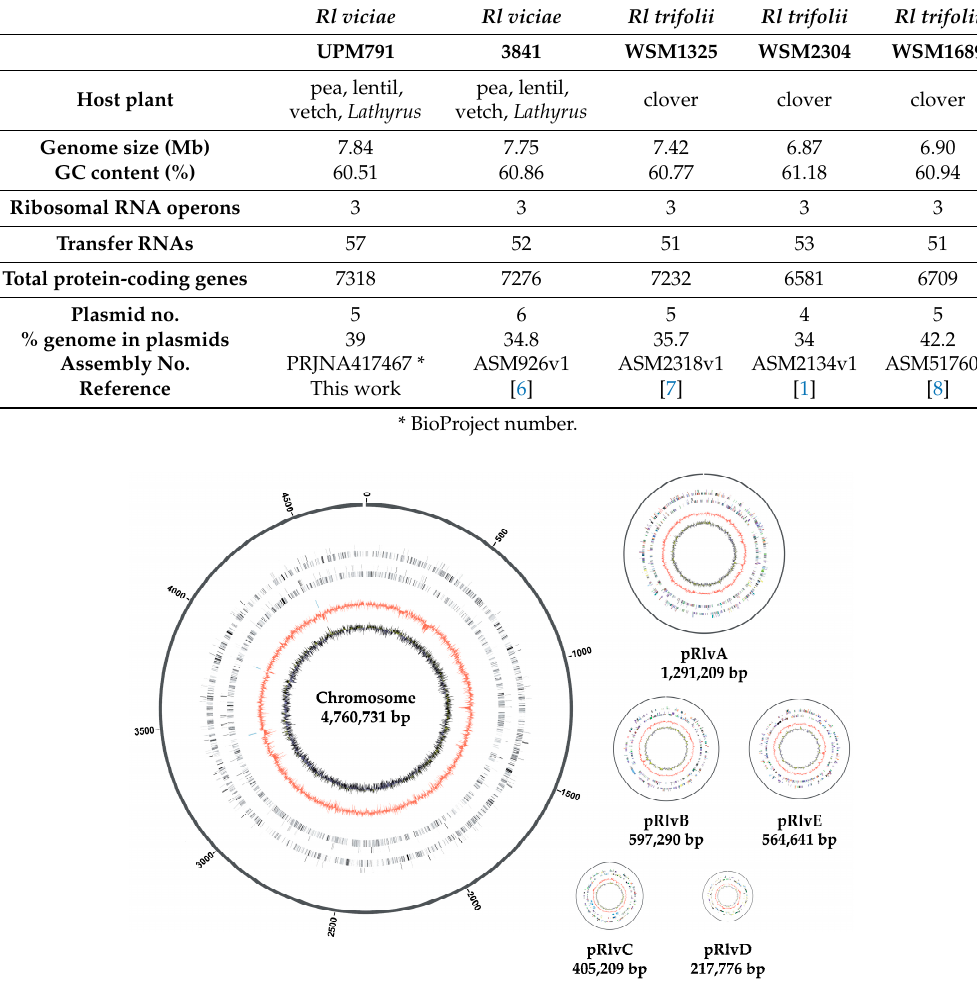
Figure 1. Genome Atlas of R. leguminosarum bv. viciae ( Rlv ) UPM791 chromosome and